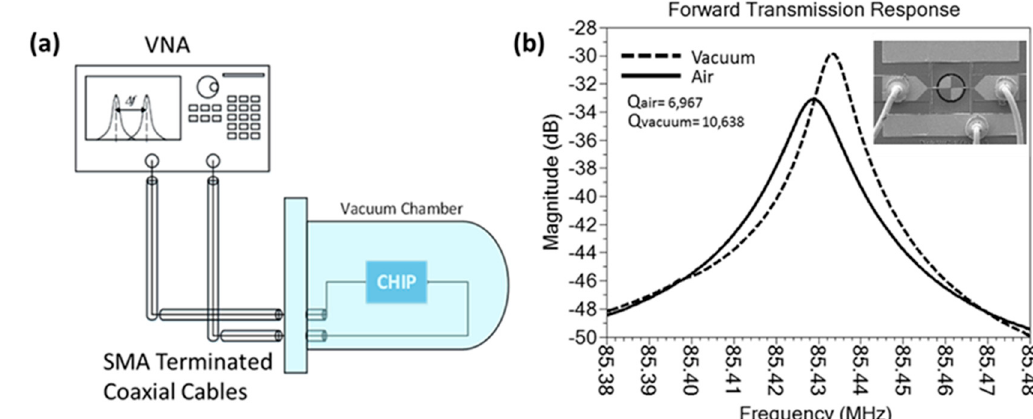
Figure 6. ( a ) Schematic diagram of the custom-built vacuum chamber test set-up used to characterize the resonant mass sensors under controlled environment; and ( b ) measured frequency responses of the ZnO-on-SOI resonator in both vacuum and air.